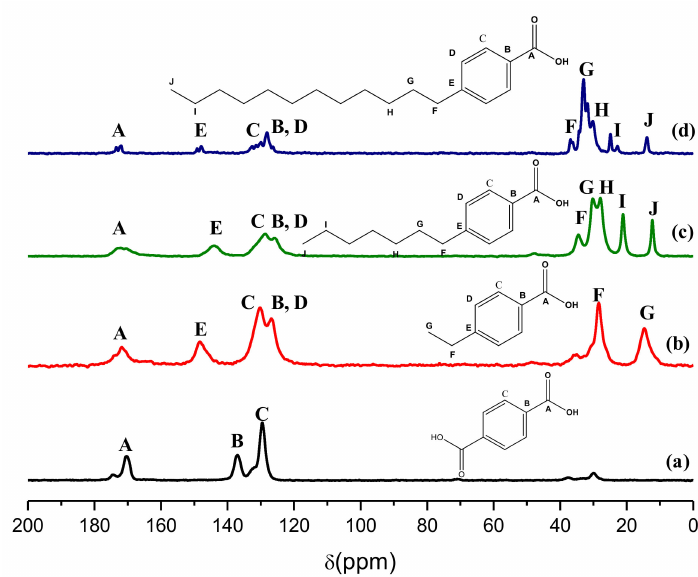
Figure 4. 13 C Magic Angle Spinning (MAS) Nuclear Magnetic Resonance (NMR) spectra: ( a ) MIL-53(Al), ( b ) Al-ITQ-EB, ( c ) Al-ITQ-HB and ( d )